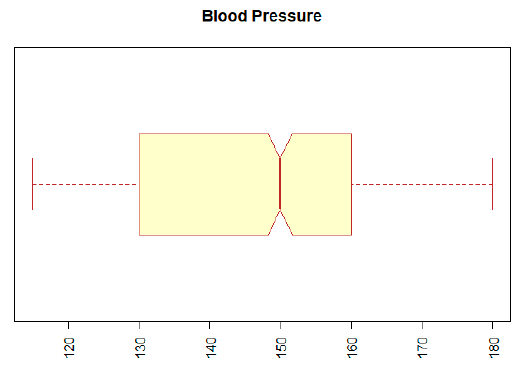
Figure 3. Boxplot for attribute BP (blood pressure).